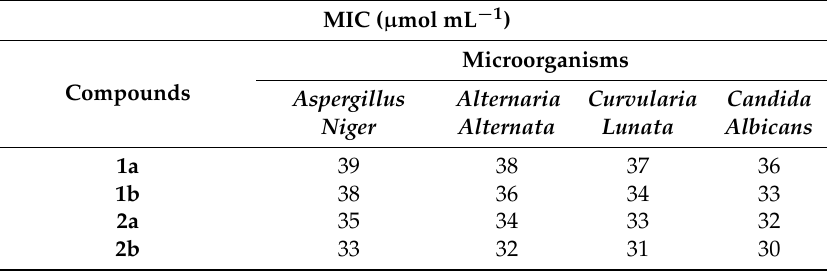
Table 2. A minimum inhibitory concentration of the compounds against